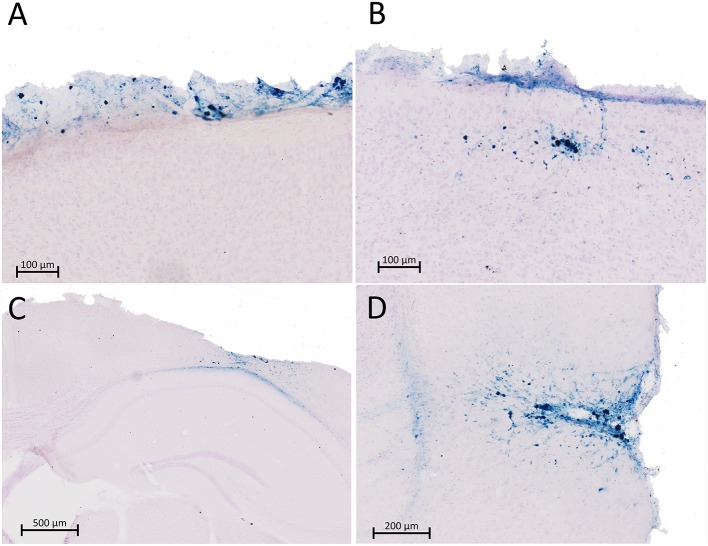
Prussian blue (PB) staining was performed in 29 mice for microbleeds after rCBI. Sections shown in (A–D) represent four different animals that stained positive for microbleeds. Eleven injured mice were negative for PB staining (not shown). Most mice positive for PB staining presented with microbleeds limited to the surface of the brain in the glia limitans (n = 11; A) or extending into the most superficial layers of the cortex (n = 5; B). A very limited number of animals had more severe injury involving the corpus callosum (n = 2; C) or temporal regions of cortex (n = 3; D). Two mice had both mild surface bleeds (A) and temporal bleeding (C).